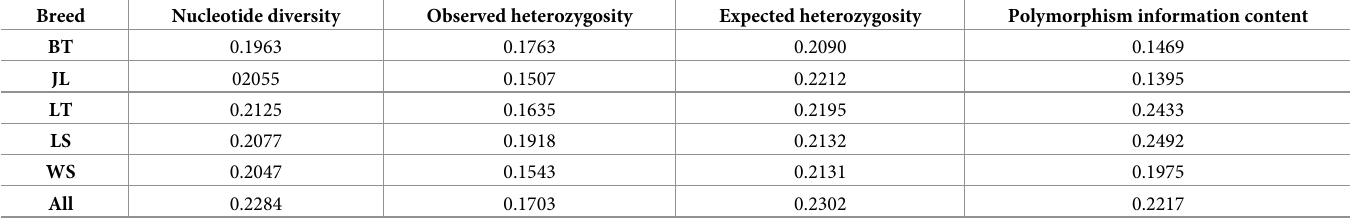
Table 1. Genetic diversity among the five sheep breeds.